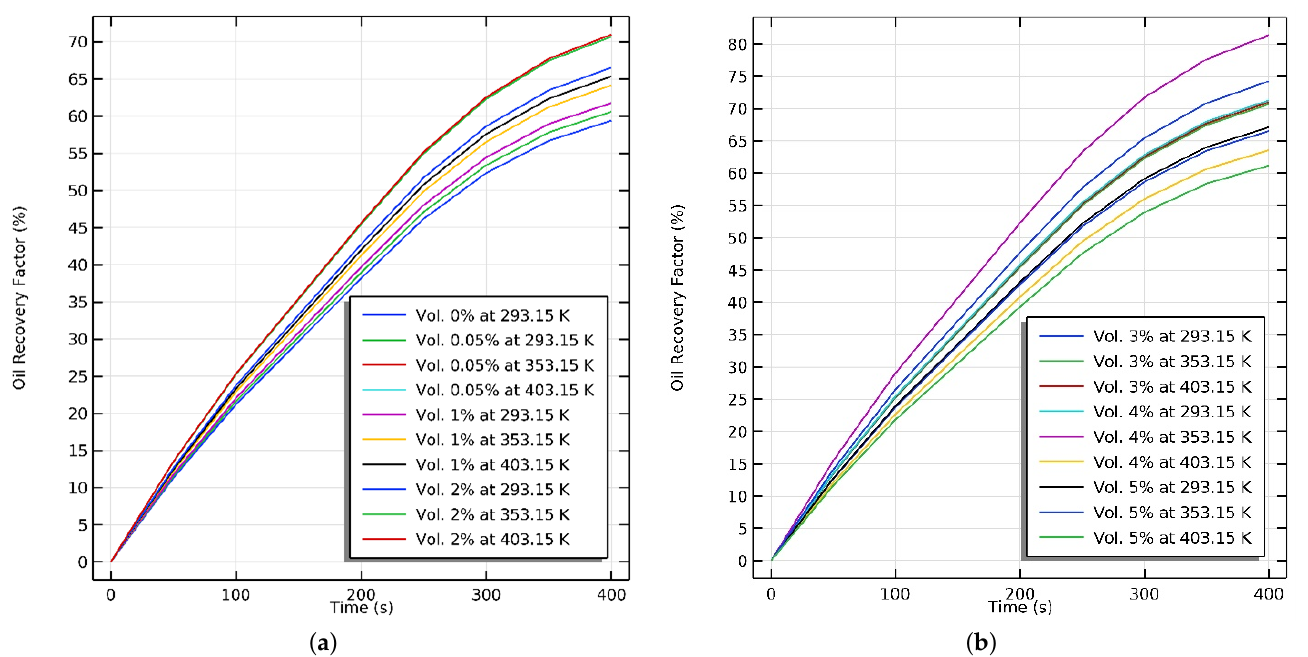
Figure 18. ( a ) The different inlet fluid temperatures effect of ideal NP SiO 2 on ORF at VFs (0.05, 1, 2%) and ( b ) At VFs (3, 4,